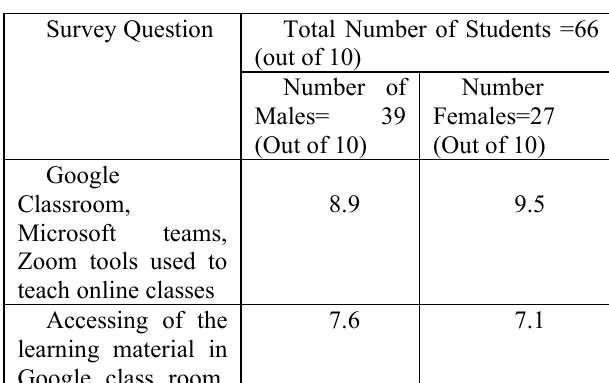
Table 8. Learner responses on online